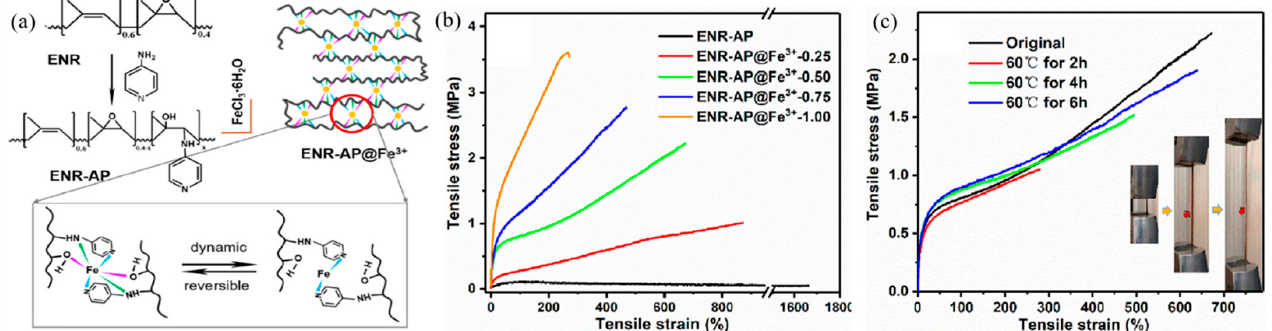
Figure 10. Self-healing of ENR elastomers via amino groups and their mechanical properties; ( a ) the mechanism of ENR elastomer with metals and pyridine ligands, ( b , c ) the stress–strain curves of ENR elastomer with various Fe 3+ content and various self-healing times at 60 °C [91]. Adapted from [91], Copyright 2021, with permission from Elsevier.